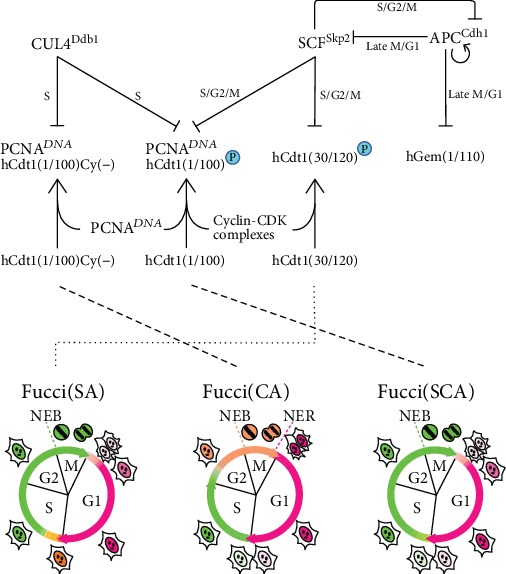
Cell cycle-phasing capabilities of the Fucci technology. Cell cycle regulations involving E3 ligase activities of CUL4Ddb1, SCFSkp2, and APCCdh1. Molecules whose intracellular concentrations or enzymatic activities change in a cell cycle-dependent manner are shown in color. PCNADNA: DNA-bound PCNA. Data adapted from Sakaue-Sawano et al. [164].